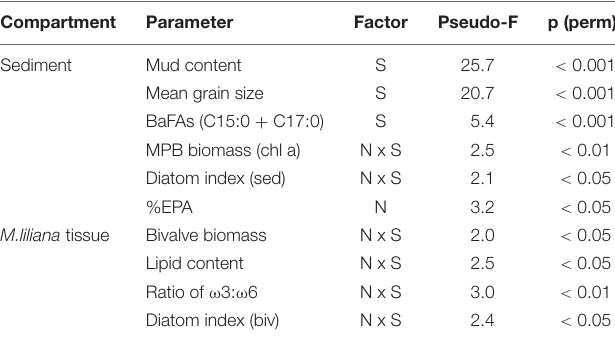
TABLE 3 | Results of univariate Permanova tests for differences in sediment and biochemical properties using nitrogen enrichment (N) (fixed) and site (S) (random) as